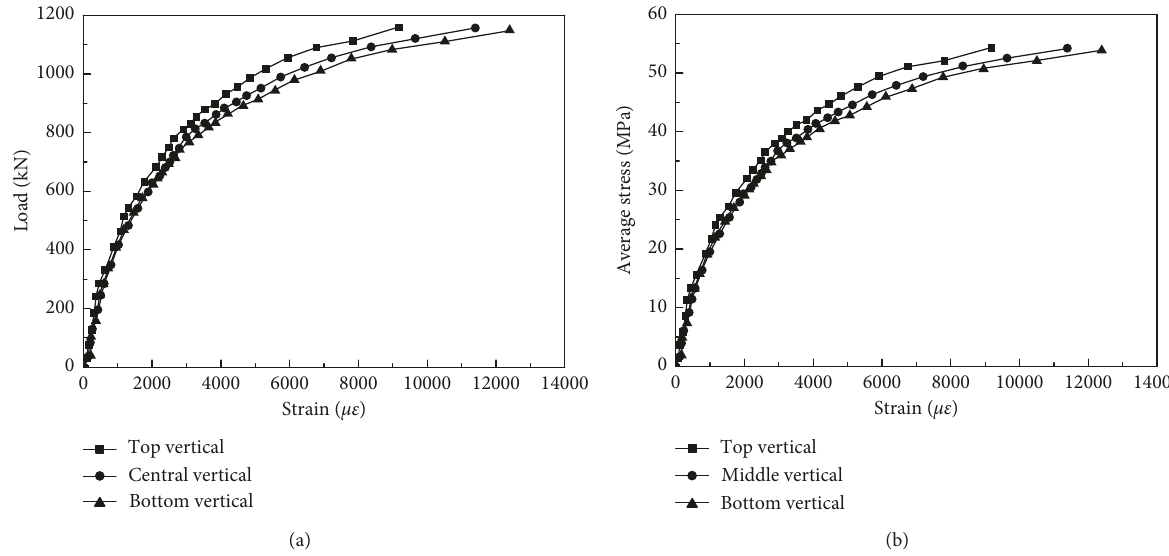
Figure 14: Vertical strain development laws of specimen RS-B-2 with steel casing. (a) Relationship of loop strain development with load. (b) Relationship of loop strain development with average